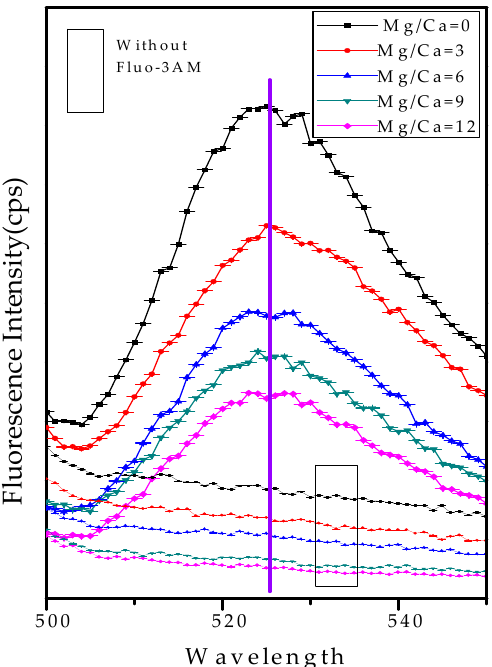
Figure 13. The fluorescence intensity of intracellular Ca 2+ ions at different Mg/Ca molar ratios.